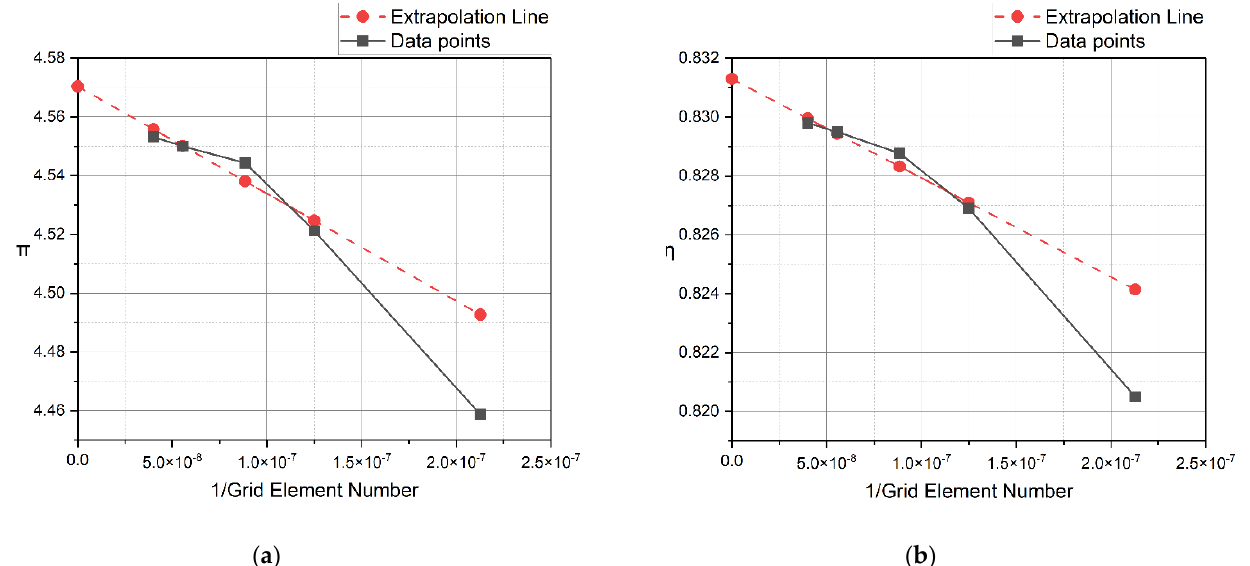
Figure 2. Grid independence and extrapolation results: ( a ) pressure ratio, π; ( b ) adiabatic efficiency, η.